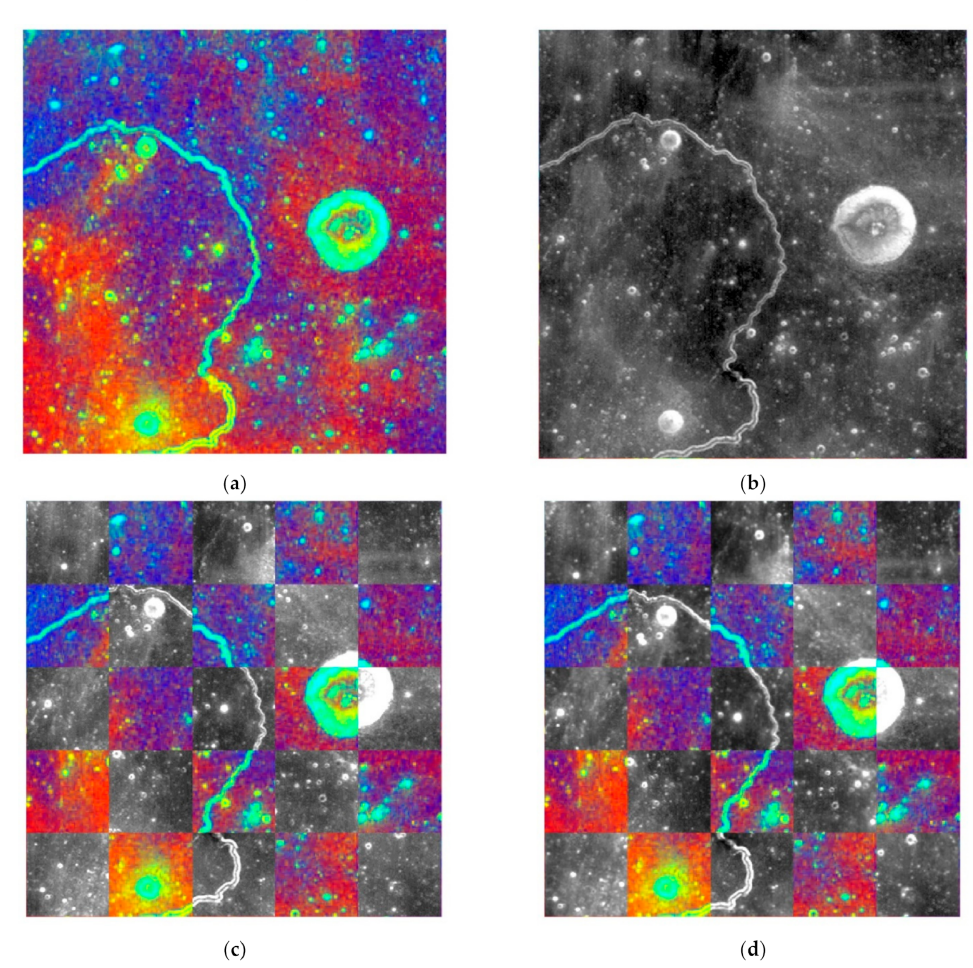
Figure 9. Examples of registration results of Moon Clementine UVVIS Warped Color Ratio Mosaic 200 m and CE1_TMap_GDOM_120m in the 2 ◦ × 2 ◦ block centered at (47.88 ◦ W, 16.27 ◦ N). ( a ) Reference image; ( b ) source image; ( c ) checkerboard composite of the reference and the pre-registered source images; ( d ) checkerboard composite of the reference and the registered source